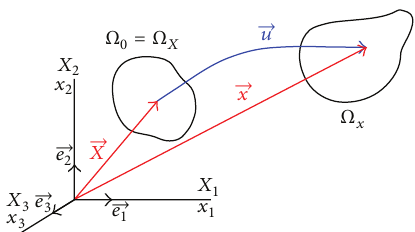
Figure 2: Initial and final configuration during a transformation.